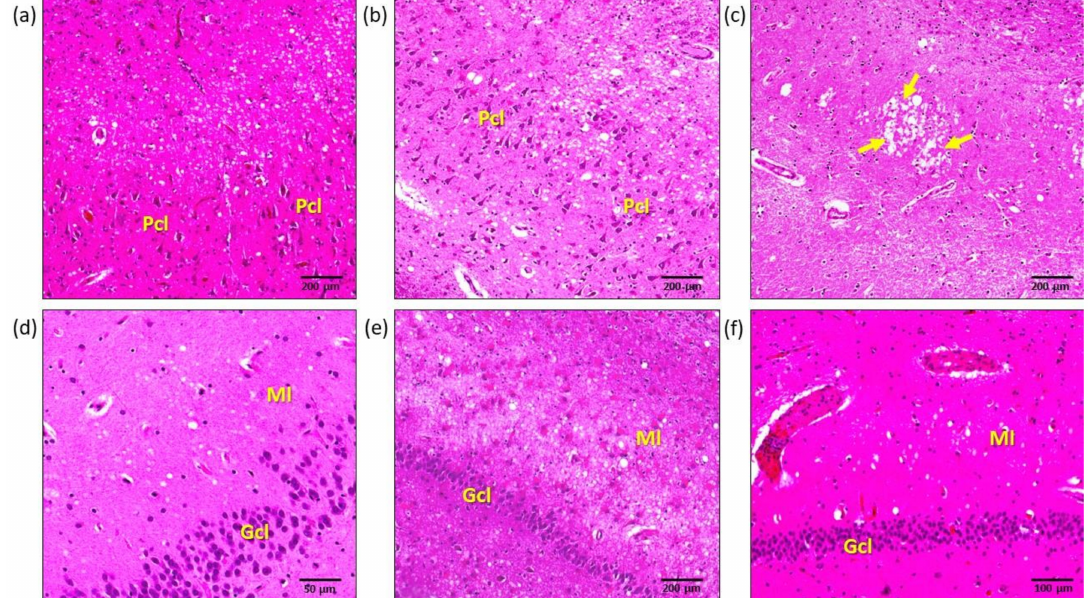
Figure 2. Microphotographs of characteristic histological lesions observed with hematoxylin-eosin stain in the hippocampus of cases included in this study. ( a ) CA2 hippocampus sector in a sCJD MM/MV1 case, showing mild spongiosis in the pyramidal cell layer ( stratum pyramidale ) and intense spongiosis in superficial layers. ( b ) CA2 sector in sCJD VV2 case, where intense spongiosis affects both the pyramidal cell layer and superficial layers. ( c ) Lacunosum-moleculare layer of the hippocampus at the CA2 level in a vCJD case, showing a characteristic pattern of spongiosis including a cluster of “florid plaques” (arrows). ( d ) Dentate gyrus of a sCJD MM/MV1 case, with minimal spongiosis in the molecular layer. ( e ) Intense dentate gyrus spongiosis and astrocytosis in a sCJD VV2 case. Note the presence of abundant hypertrophic astrocytes in all layers. ( f ) Minimal spongiosis in the dentate gyrus of a sCJD VV1 case. Pcl : pyramidal cell layer; Gcl : granular cell layer; Ml : molecular